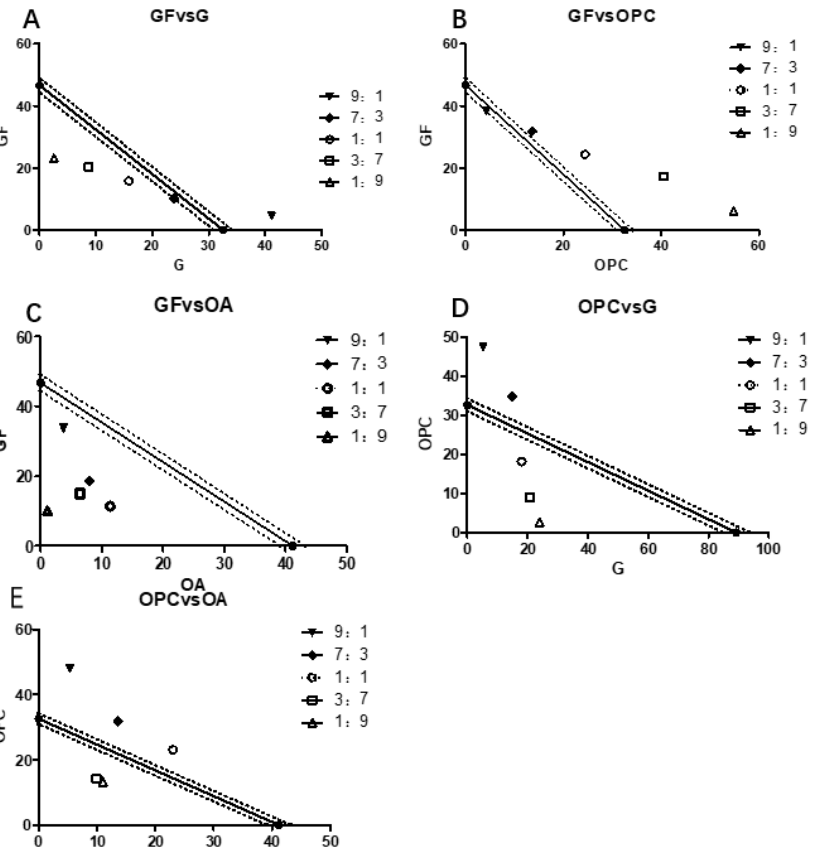
Figure 3. EGB synergistic effect of each functional component on LPS stimulation Raws264.7 and NO inhibitory activity. (Where, ( A ) is the isoradiometric figure of GF and G at different compounding proportions. ( B ) is the complex of GF and OPC in different proportions. ( C ) is the compound of GF and OA in different proportions. ( D ) is the complex of OPC and G in different proportions. ( E ) is the complex of OPC and OA in different proportions.). Table 2. Each functional component of EGB was combined with statistical analysis results.